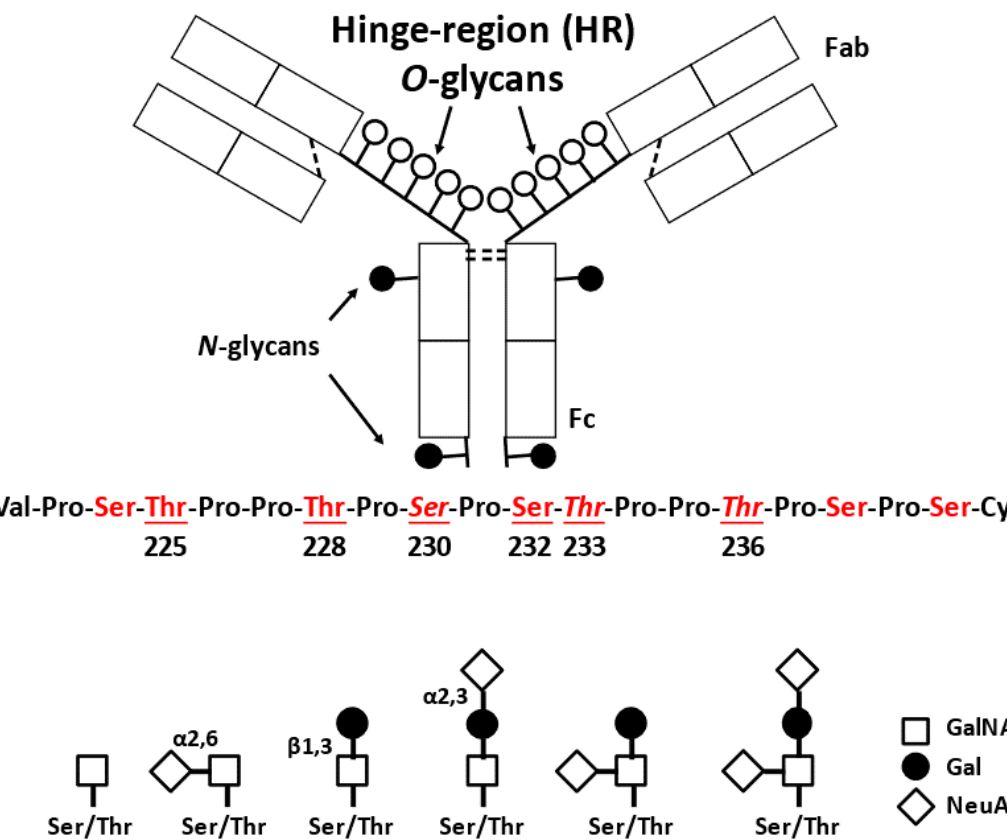
Figure 2. Schematic representation of human IgA1. The IgA1 heavy chain has three to six O -glycans in its hinge region (HR) and two N -glycosylation sites [46,54]. There are nine potential O -glycosylation sites, marked in red font, of which up to six sites can be O -glycosylated (underlined serine (Ser) and threonine (Thr)). Ser/Thr in italic (230, 233, 236) show the frequent sites with galactose (Gal)-deficient O -glycan ( a ) [50,52,53,55]. There are O -glycan variants of circulatory IgA1. N -acetylgalactosamine (GalNAc) is attached to Ser/Thr residues and can be extended by the attachment of Gal to GalNAc residues. GalNAc or Gal or both can be sialylated. Due of diversity of the glycan attachment sites, the number of O -glycans in HR, and variability of O -glycan structures, IgA1-HR O -glycoforms exhibit wide heterogeneity. Gd-IgA1-specific antibodies are considered to recognize Gal-deficient IgA1 glycoforms with terminal GalNAc (left structure). NeuAc, N -acetylneuraminic acid ( b ).